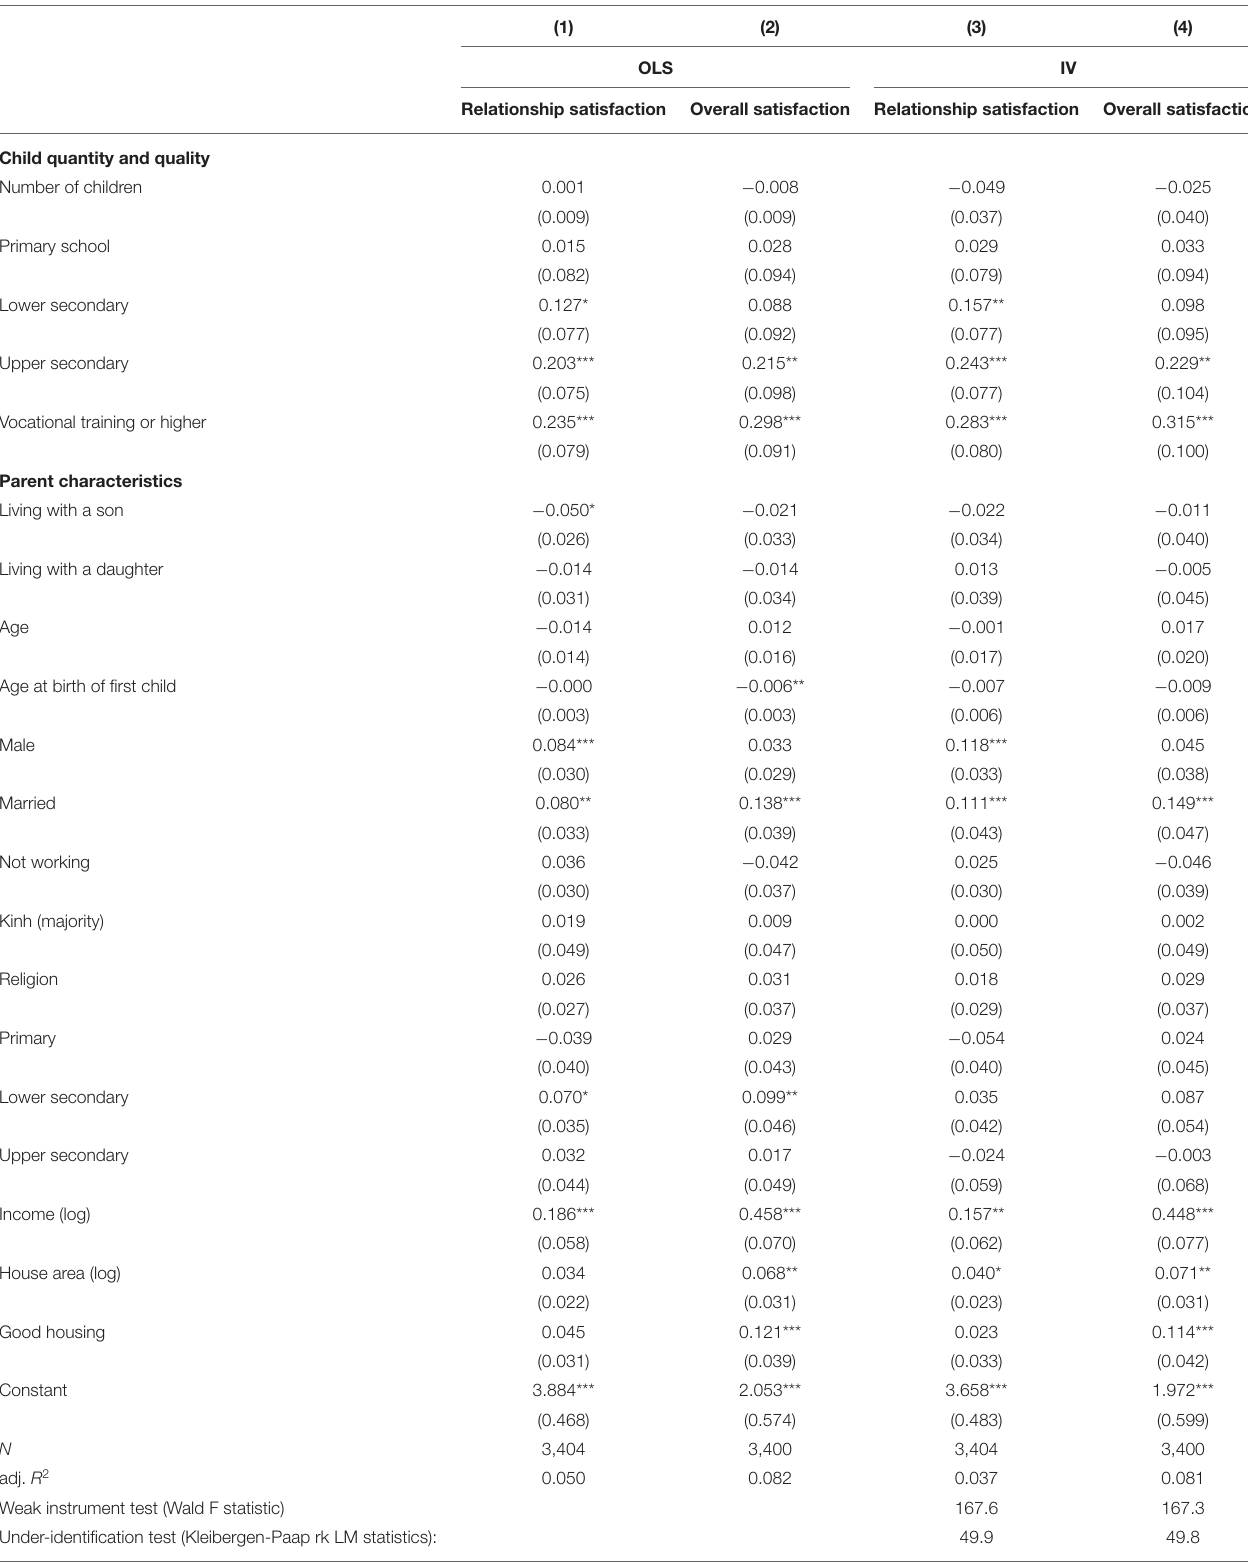
TABLE 2 | Effects on elderly parents’ life